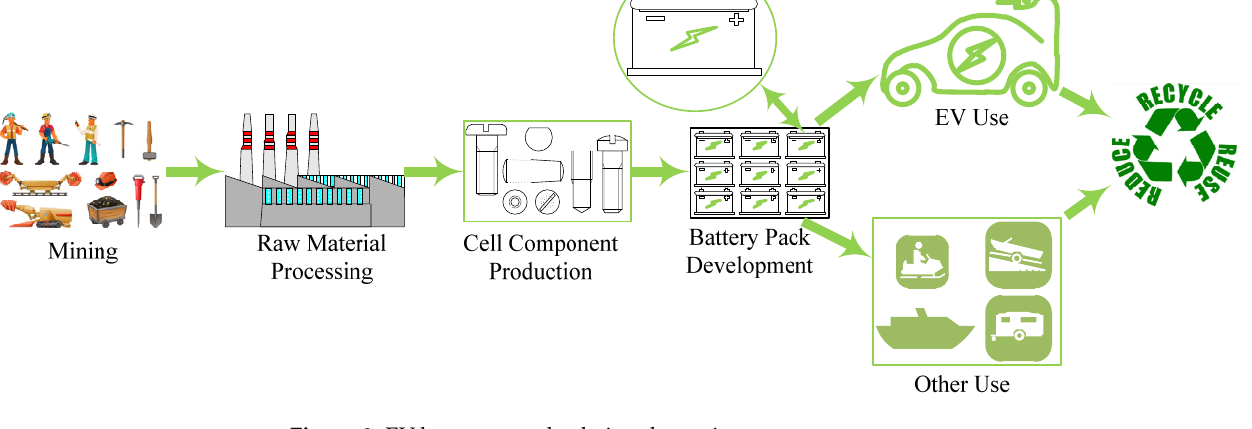
Figure 8. EV battery supply chain schematic.